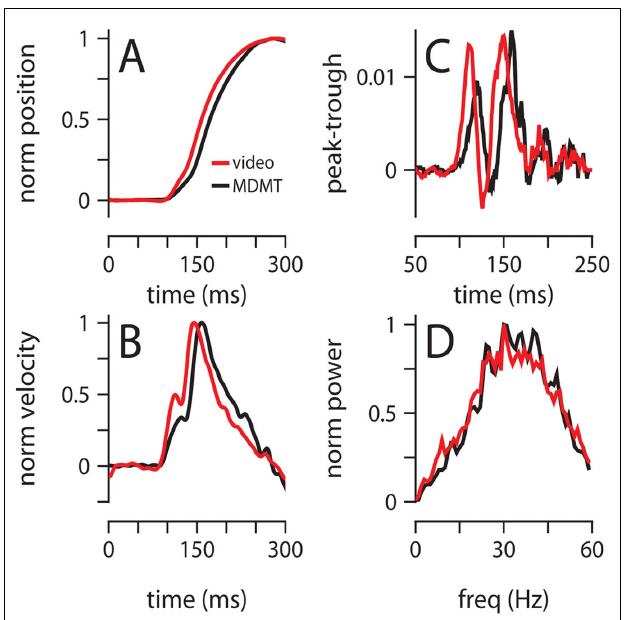
FIGURE 7 |Acquisition of the conditioned eyelid response. (A) Eyelid velocity averaged across different sessions during the training phase, for mice trained with ISIs of 175ms, (B) 250ms, (C) 325ms, and (D) 400ms. The sessions that were used to compute each average are indicated by the color code shown in (D) , where n represents number of the last training session for each mouse. FEC, fraction eyelid closure.